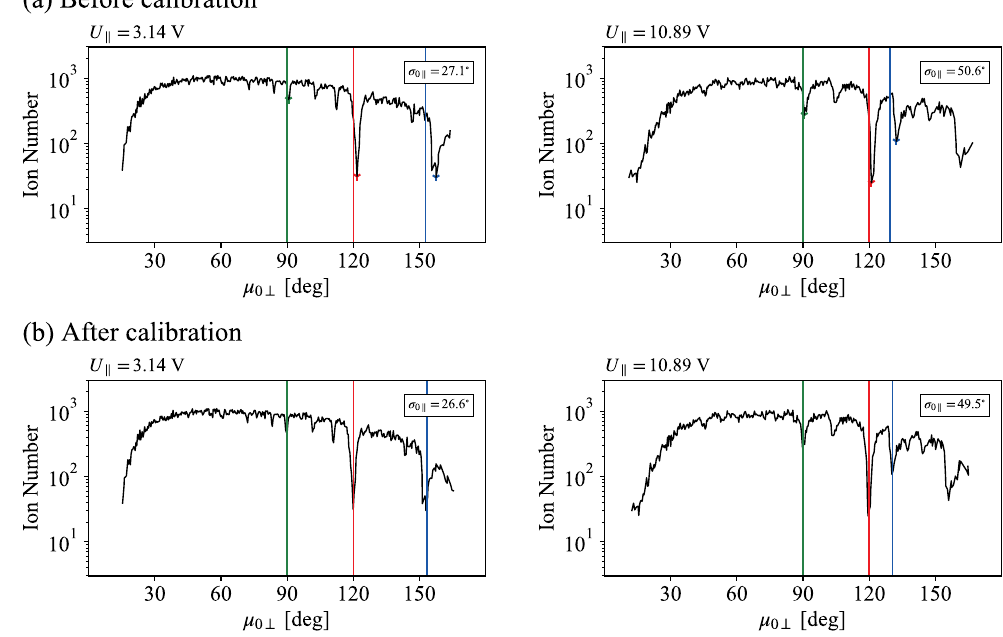
FIG. 2. Long-term ion-loss distribution in the low-density regime. The number of Ar þ ions remaining in the LPT after 1 s ( 10 6 sinusoidal periods) is measured at many different values of μ 0 ⊥ with the axial confinement bias fixed at U k ¼ 3 . 14 V and U k ¼ 10 . 89 V. Each curve consists of 360 data points. Three vertical lines indicate the locations of the resonances expected from Eq. (2) with ð n ⊥ ; n k ; n Þ ¼ ð 3 ; 0 ; 1 Þ (red), (4,0,1) (green), and (2,2,1) (blue). The ideal structural parameters, i.e., r 0 ¼ 5 . 00 mm and ¼ 8 . 23 mm, are assumed in the upper panels (a) to determine the bare phase advances. In the lower panels (b), these parameters l z ¼ 8 . 397 mm. In addition to the three resonances above, we notice several other resonances that are modified to r 0 ¼ 5 . 022 mm and l z should be of the fourth and fifth orders according to Eq. (2). For instance, the cause of the two small dips between the green and red lines in the left panels can be understood as the nonlinear resonances with ð n ⊥ ; n k ; n Þ ¼ ð 3 ; 2 ; 1 Þ and (3,1,1). These high-order resonances have only little impact on bunch stability in a short timescale corresponding to the length of a typical hadron linac, unless they are driven by strong error